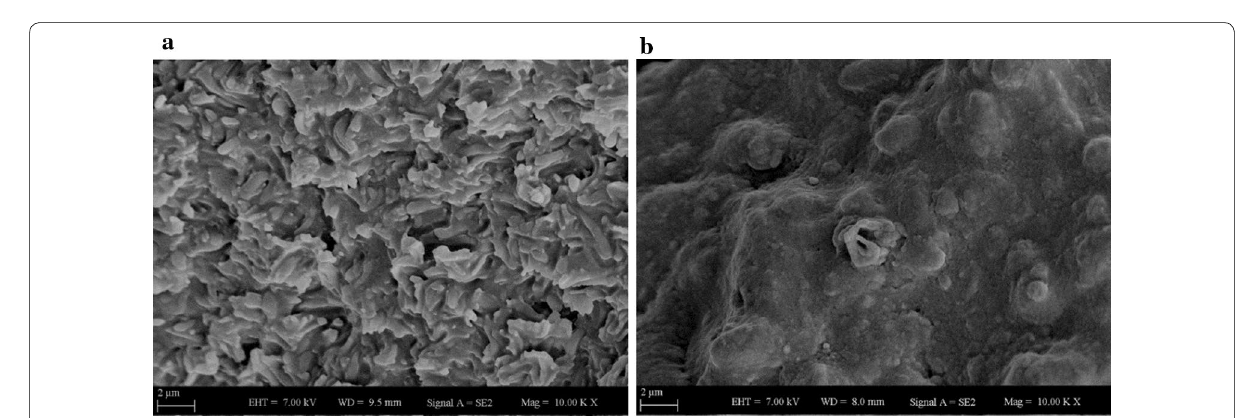
Fig. 4 SEM images of kefir grains a before and b after